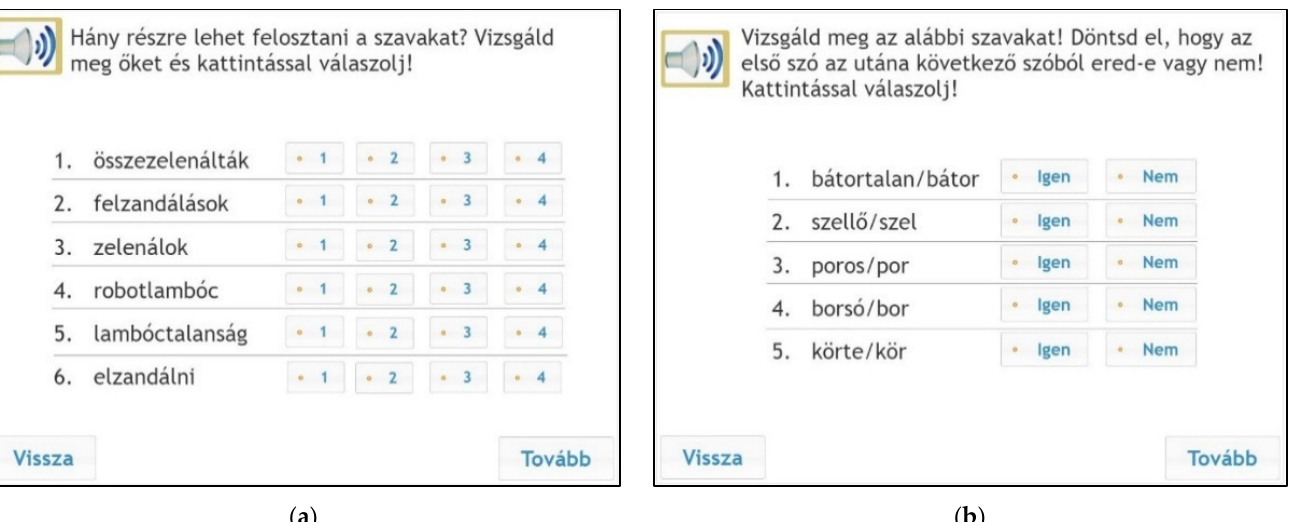
Figure 3. Samples from the morpheme segmentation subtest. Left ( a ): nonwords, instruction: “How